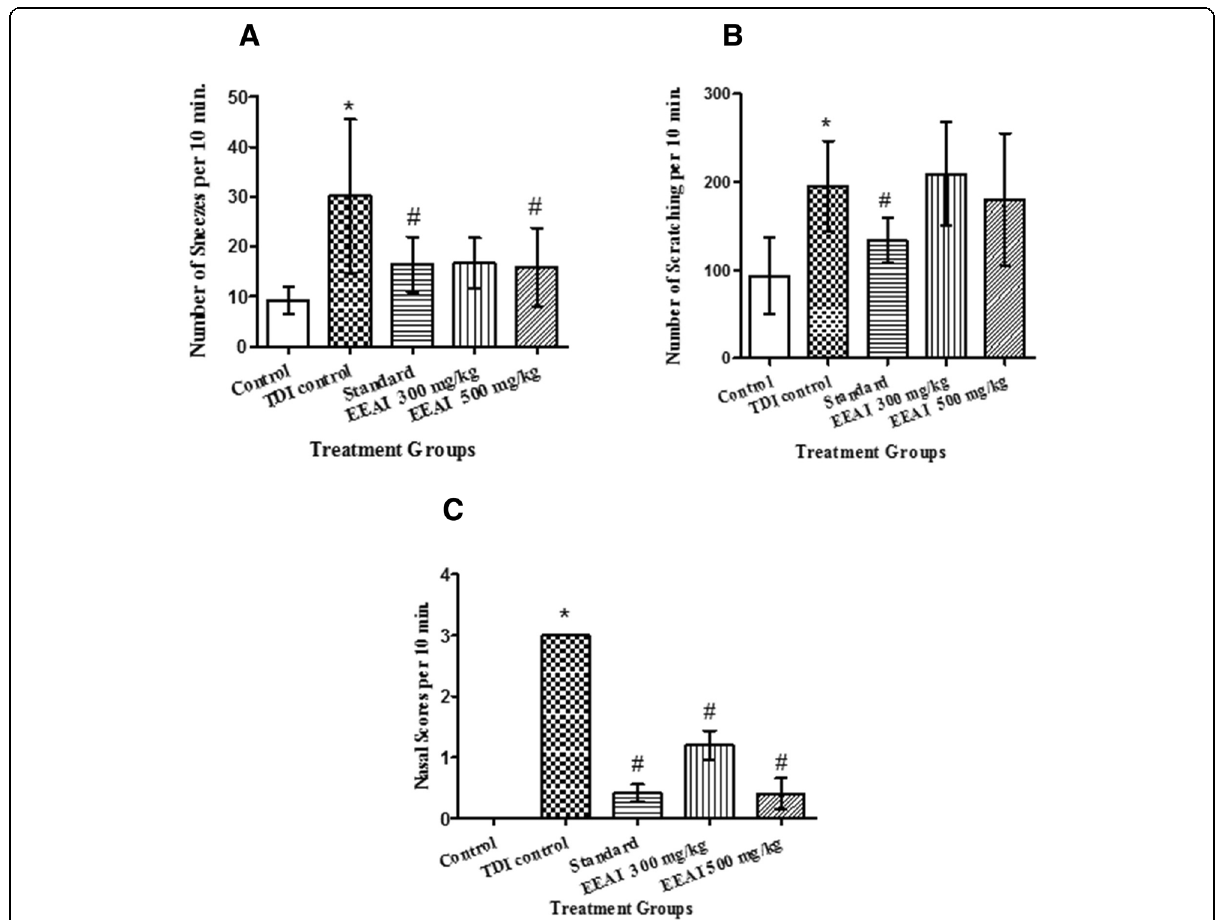
Fig. 2 a , b , c Suppressive effect of A. ilicifolius extract on Sneezing ( a ), Nasal Scratching ( b ) and Nasal Score ( c ). Values are expressed as Mean±S.D., n =10; * p <0.05 vs. Control; # p <0.05 vs. TDI